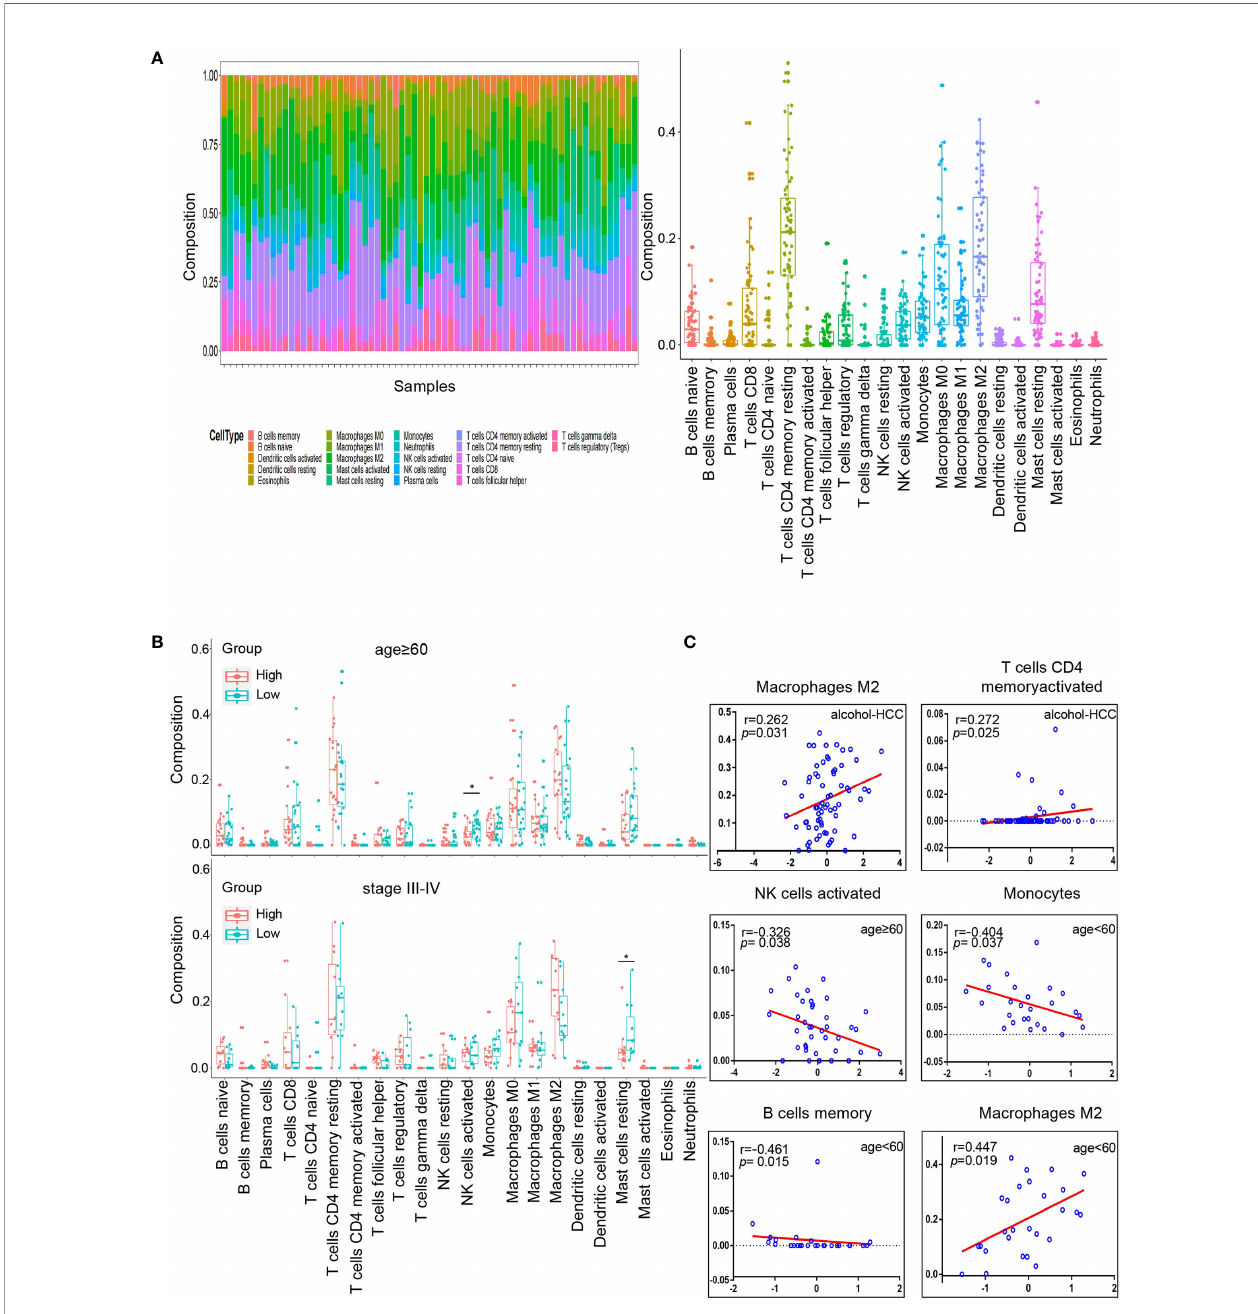
FIGURE 7 | Tumor microenvironment analysis in high and low risk groups. (A) Relative proportion of 22 immune cells in fi ltrating in alcohol-related HCC patients. (B) Differences in 22 immune cells between the high and low groups in age subgroups. The top graph is the group that age ≥ 60 and the bottom graph is the group that TNM staging III/IV. (C) Correlation analysis of immune cells and RS in different subgroups. The groups are entire groups of alcohol-related HCC, age ≥ 60 and <60 groups from left to right and from top to bottom. * P <